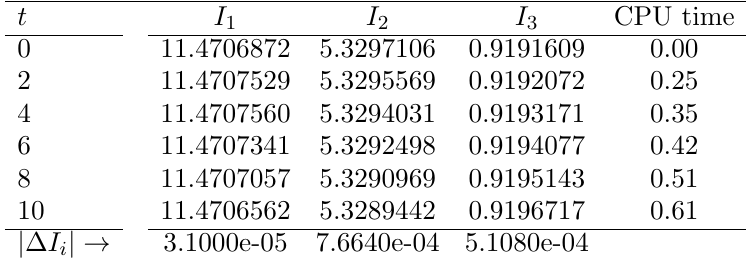
Table 13. Invariants and their changes for p = 4, N = 400 and ∆ t = 0 . 05.